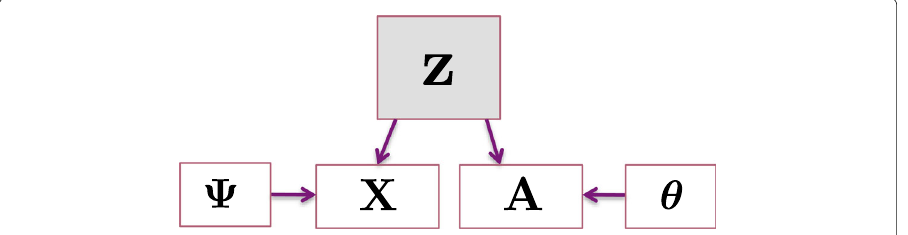
Fig. 1 Modeling community membership in terms of attributes and connectivity. Node-to-community assignments specified by Z are determined in terms of adjacency matrix information, A and attribute matrix information, X . A and X are assumed by be generated from a stochastic block model and a mixture of multivariate Gaussian distributions, parameterized by θ and (cid:3) ,